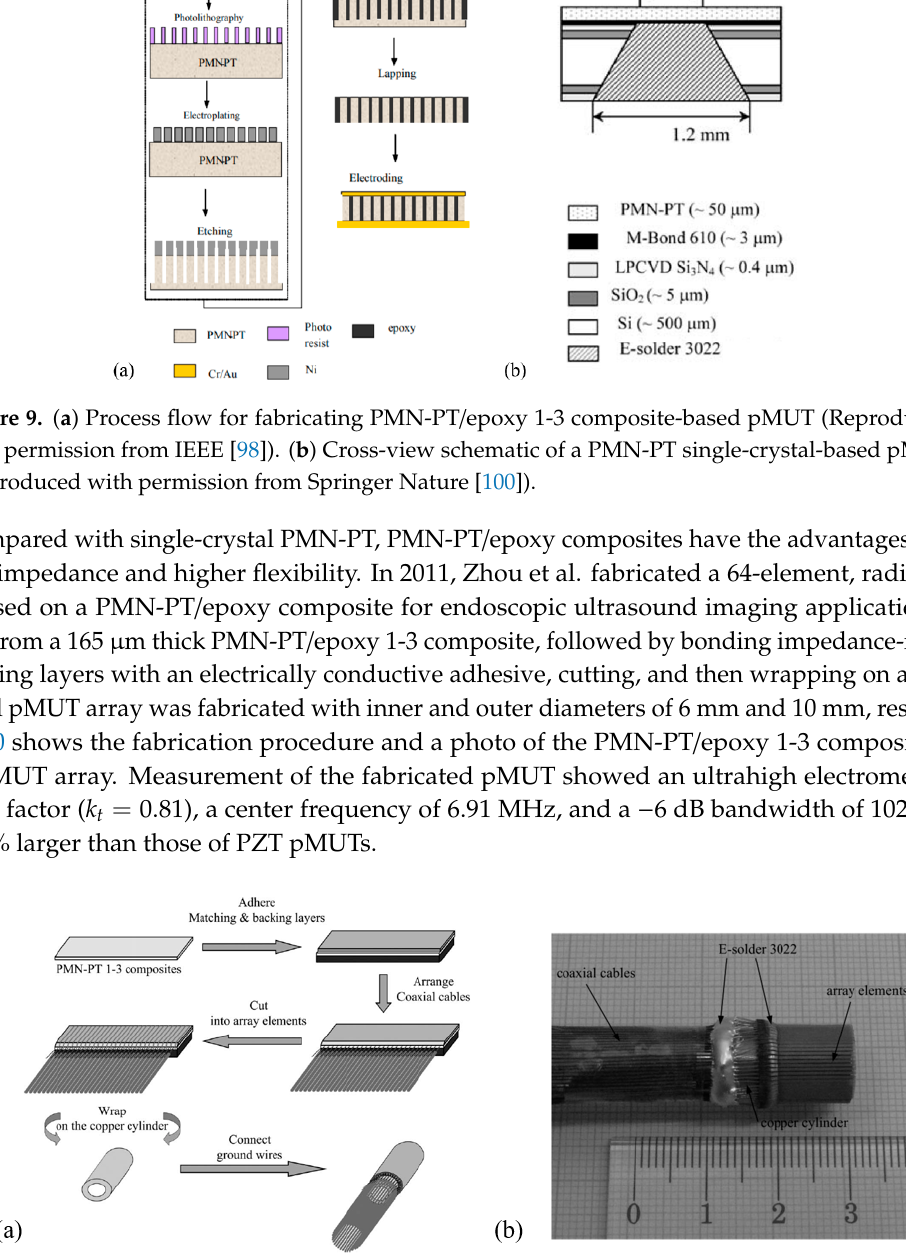
Figure 10. Fabrication process ( a ) and photograph ( b ) of a PMN-PT/epoxy 1-3 composite-based radial pMUT array (Reproduced with permission from IEEE [102]).